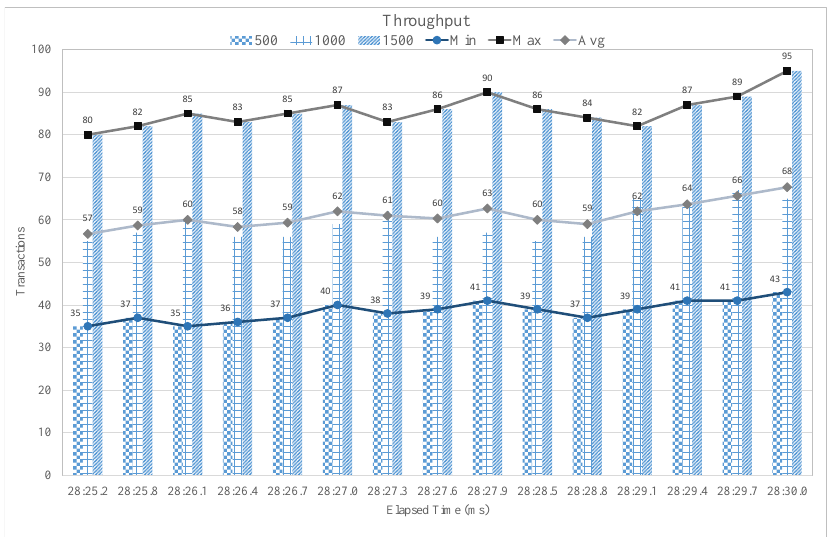
Figure 12. Transaction Per